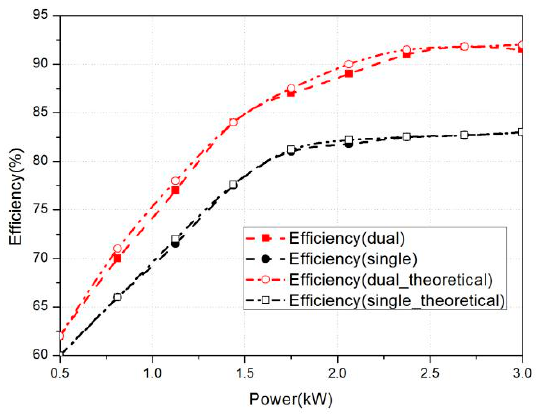
Figure 16. System DC-DC efficiency.